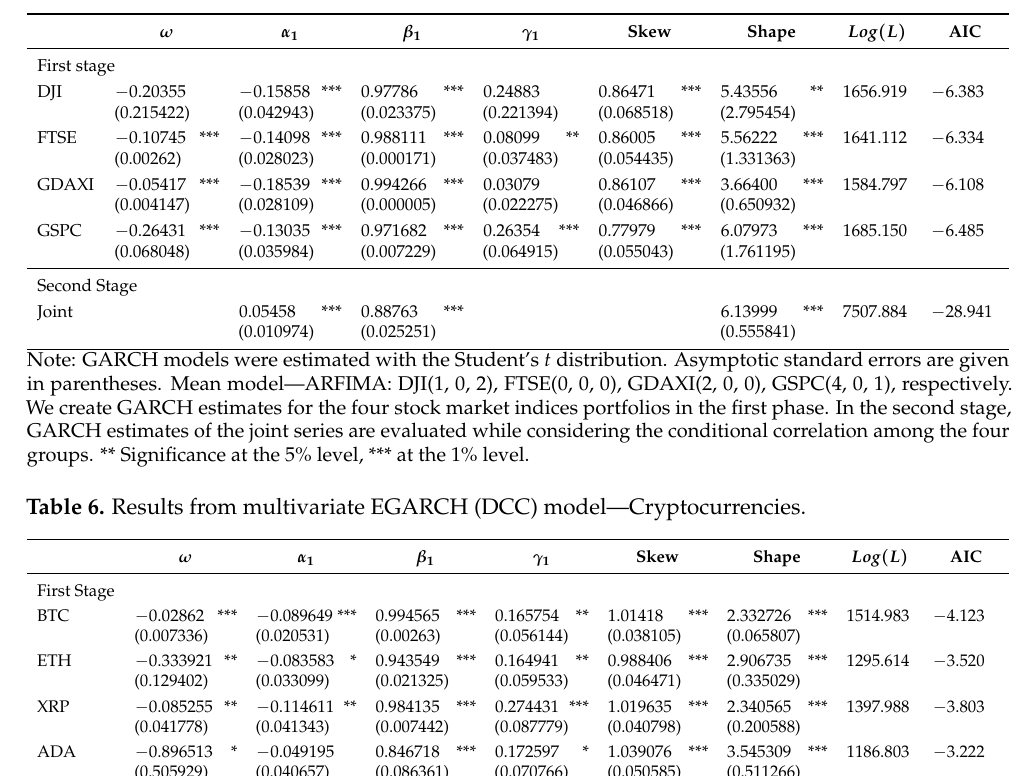
Table 5. Results from multivariate EGARCH (DCC) model—Stock Market Indices.